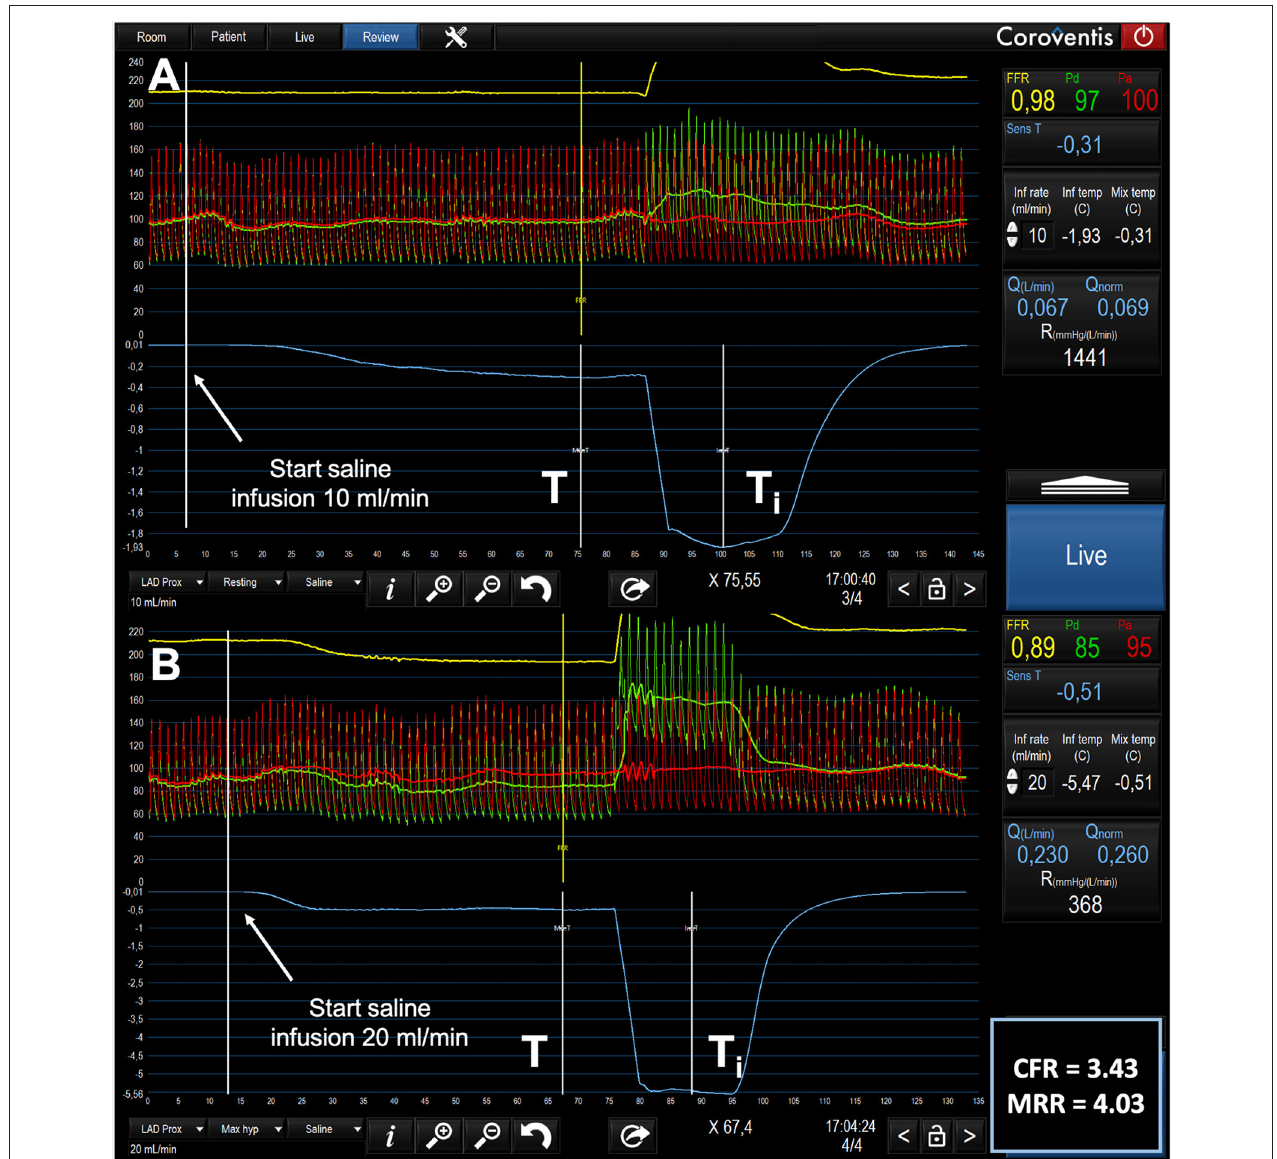
FIGURE 1 | Example of tracings of phasic and mean central aortic pressure (Pa), distal coronary pressure (Pd) and thermodilution during the infusion of 10 mL/min (A) and of 20 mL/min (B) in the LAD of a 77-year-old male patients with mild wall irregularities. (A) after the start and during the next 70s of the infusion of saline at 10 mL/min through the RayFlow TM catheter located in the proximal LAD, no changes in Pd / Pa were observed. Resting flow is 67 mL/min. (B) in contrast, after the start and during the next 70s, the infusion of saline at 20 mL/min through the RayFlow TM catheter located in the proximal LAD, was paralleled by a decrease in Pd and in Pd/Pa. Hyperemic flow is 230 mL/min. CFR and MRR are 3.43 and 4.03 respectively. Q, Absolute Flow; Qnorm, Normalized Absolute Flow (Q/FFR); R, Absolute Microvascular Resistance; CFR, Coronary Flow Reserve; MRR, Microvascular resistance Reserve.